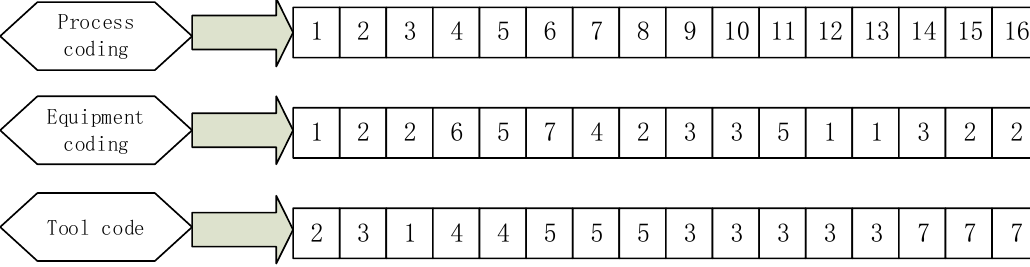
Figure 3. The flow of Grey Wolf Optimizer (GWO).